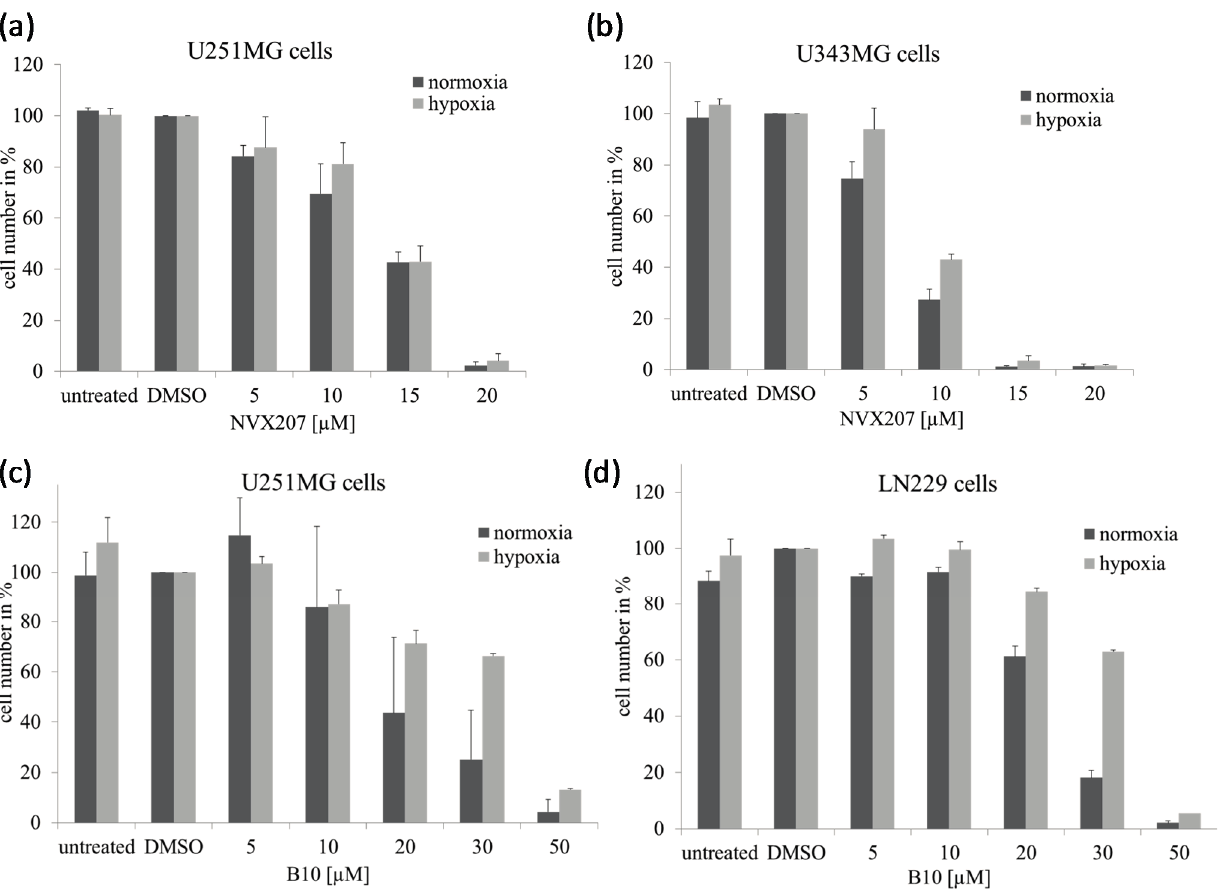
Figure 2. Effects of NVX-207 and B10 on the cell growth of glioma cells. Cell number of glioma cells after treatment with NVX-207 or B10 for 24 h under normoxic or hypoxic conditions. Under hypoxia, NVX-207 ( a , b ) and B10 ( c , d ) did not show decreased cell growth in glioma cell lines compared to normoxic conditions. The data represent the mean values (±SD) of three independent